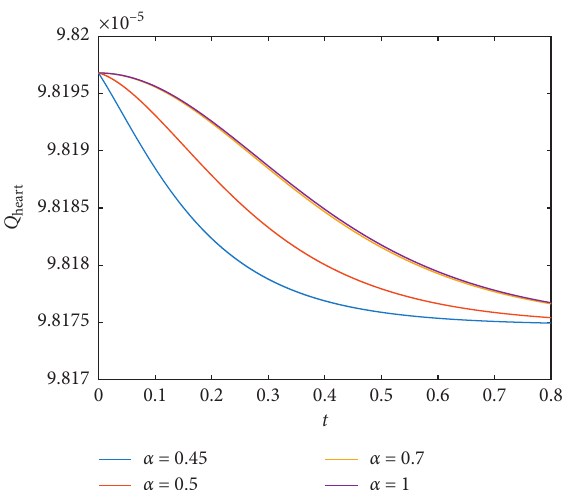
Figure 4: The blood flow volume of cardiac outlet at the different values of time and α ( 􏽥 c � 0 )